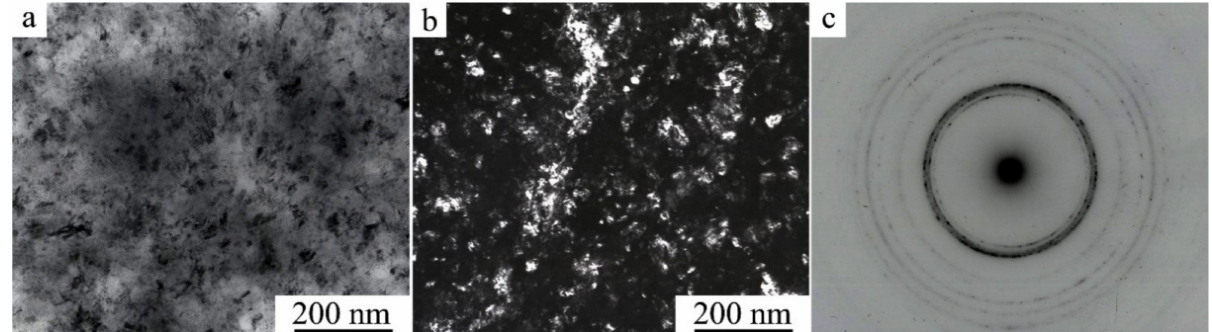
Figure 11. ( a ) Bright- and ( b ) dark-field TEM images of the microstructure and ( c ) the corresponding SAED pattern for the Cu–13.5Al–3.5Ni alloy after its quenching from 1223 K and HPT of 10 revs.